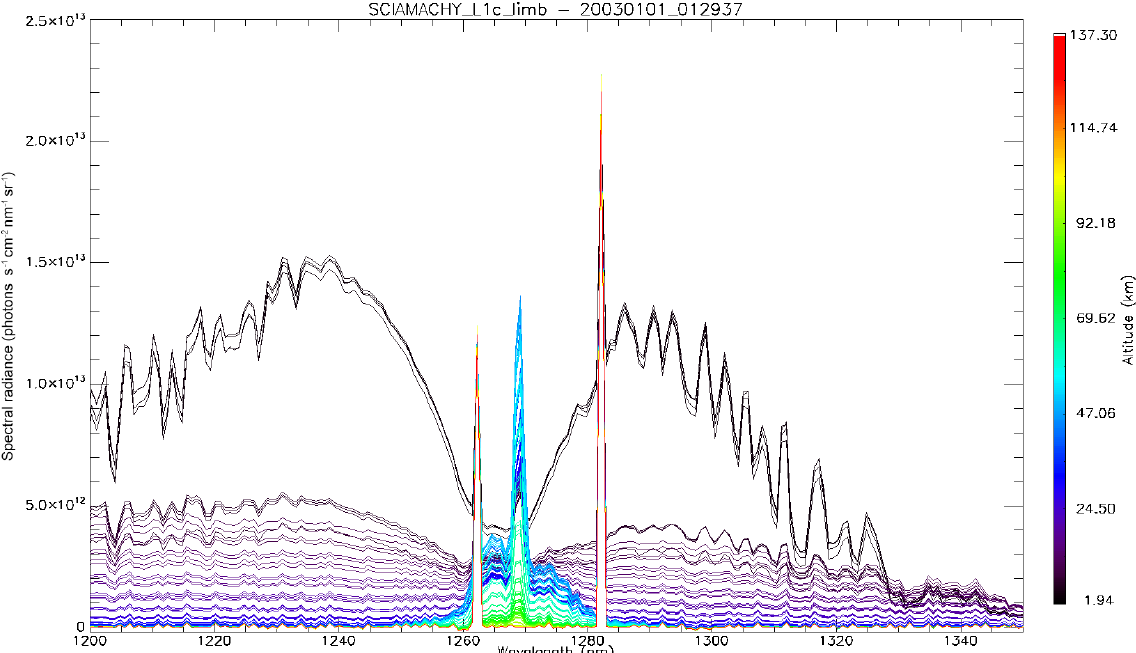
Figure F2. Spectra corrected from the high-altitude spectrum still showing two bad pixels at wavelength 1262.267 and 1282.128nm. We replaced their value by the average of their two surrounding pixels to obtain spectra of Fig. F3. The tangent altitude of the LOS is colour coding each spectrum.